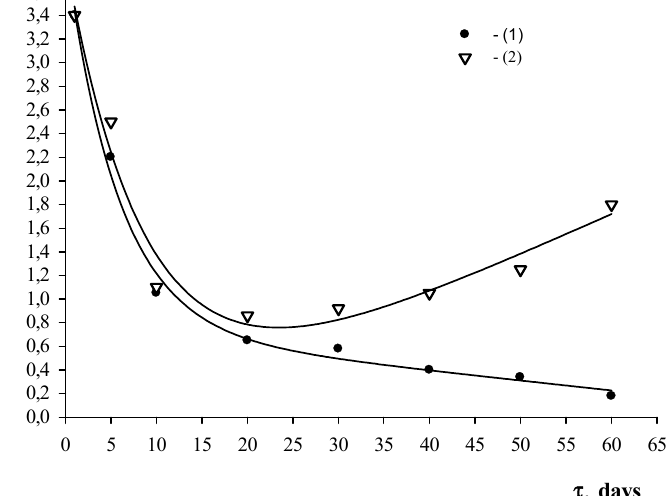
Figure 2. Variation of the corrosion rate of the plate with a weld joint (sample No. 4) in the solution containing NaCl. 1—in static conditions; 2—with